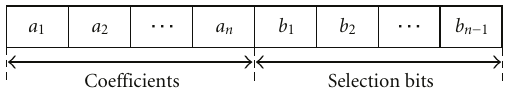
Figure 2: The individual defined in EDFE. Each coe ffi cient is represented by 11